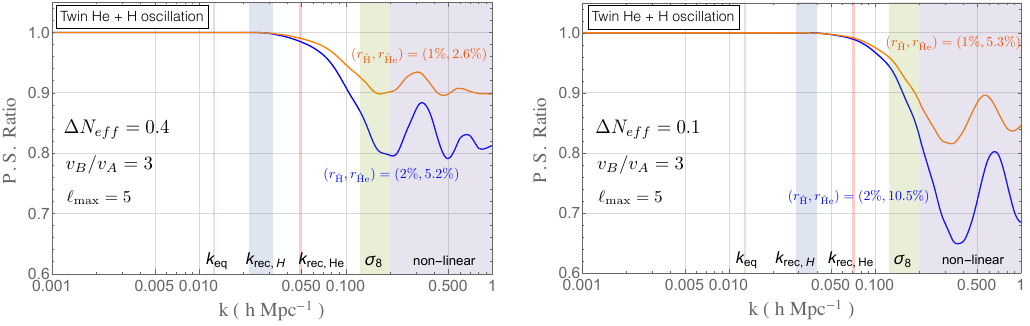
Figure 5 . Ratio of matter power spectrum between (cid:3)CDM+MTH and (cid:3)CDM+DR, including both the twin helium and hydrogen oscillations. The twin helium mass fractions are taken from (cid:12)gure 1. k rec ; He corresponds to the time of twin helium recombination as obtained from the Saha equation eq.